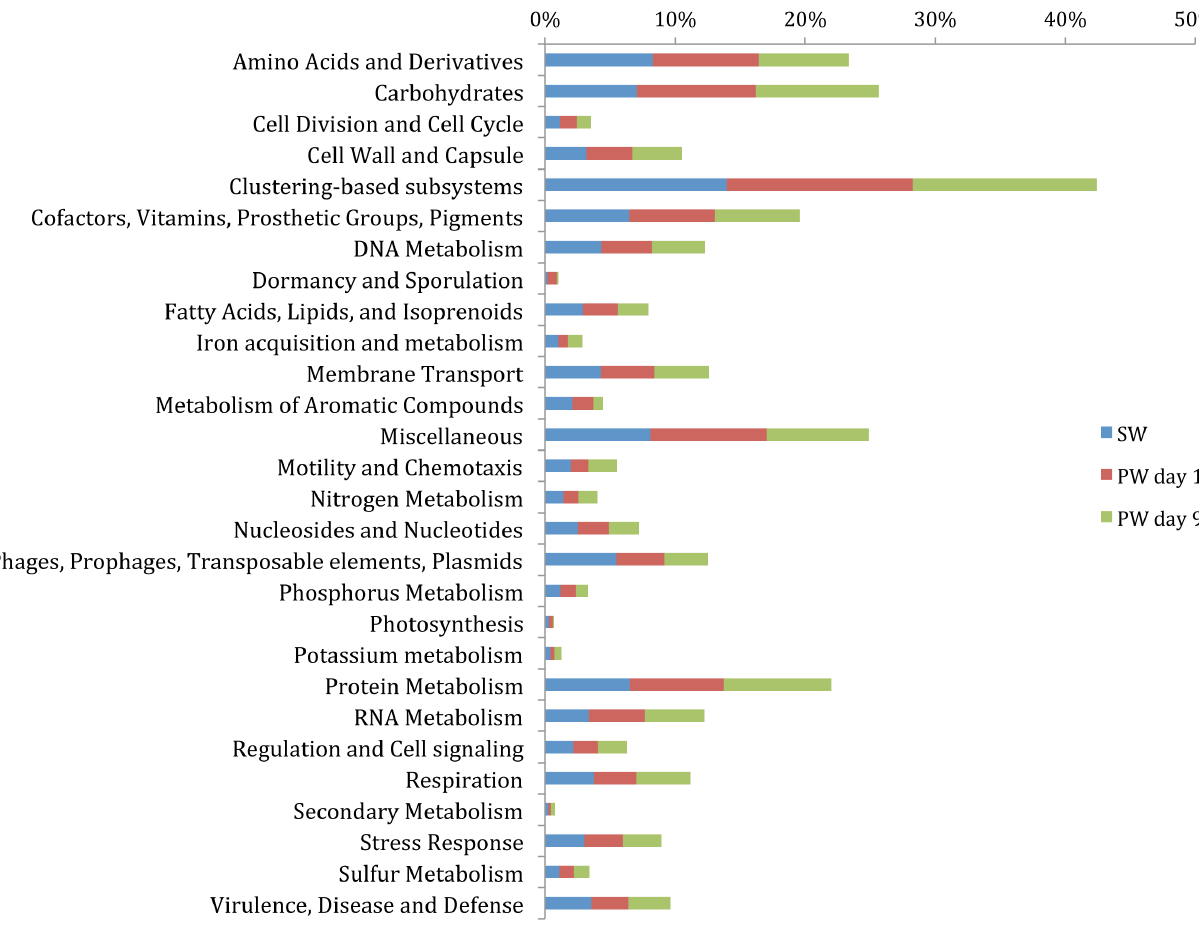
Figure 5. Actual abundance of contigs belonging to Level 1 functional categories in source water (SW), produced water day 1 (PW day 1) and produced water day 9 (PW day 9). Functional annotations were assigned based on the Subsystems database.